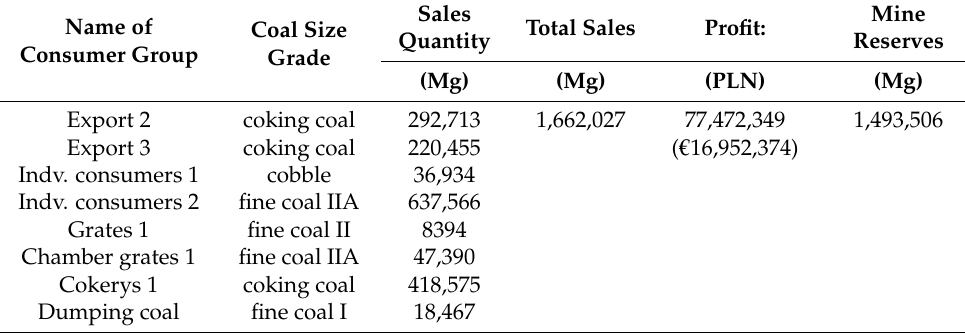
Table A7. The optimal production and sales plan for mine “D” for 2021.